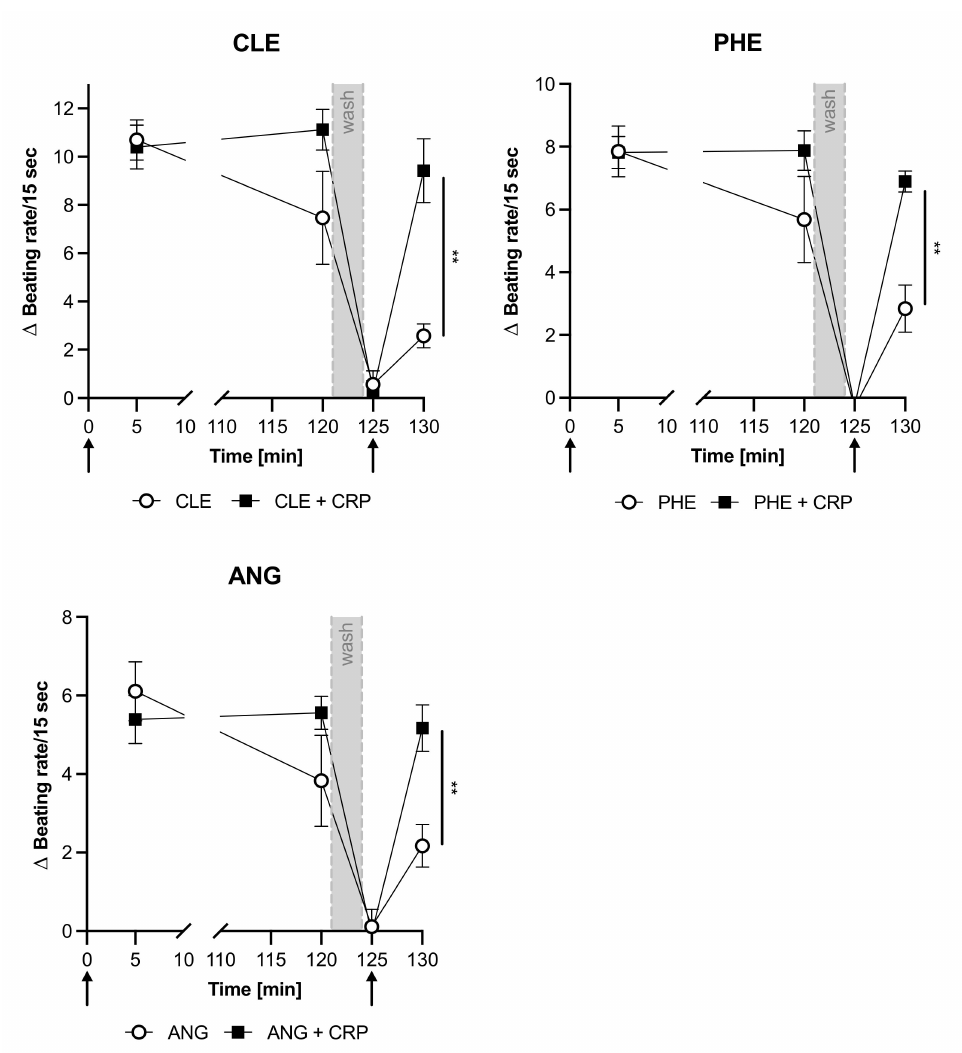
Figure 2. CRP blocks the desensitization of stimulated neonatal rat cardiomyocytes. Difference of cardiomyocyte beating rates [ ∆ Beating rate/15 s] modulated by agonists clenbuterol (CLE), phenylephrine (PHE) and angiotensin II (ANG) with or without CRP co-incubation. Mean of 3– 5 independent experiments ± standard deviation is depicted. Arrows indicate stimulation with respective agonists. Grey area indicates washing step. After the washing step, the agonist was added again but no CRP. Significance of difference between CRP incubated and control group at the last time point was calculated with student’s t -test. ** p <